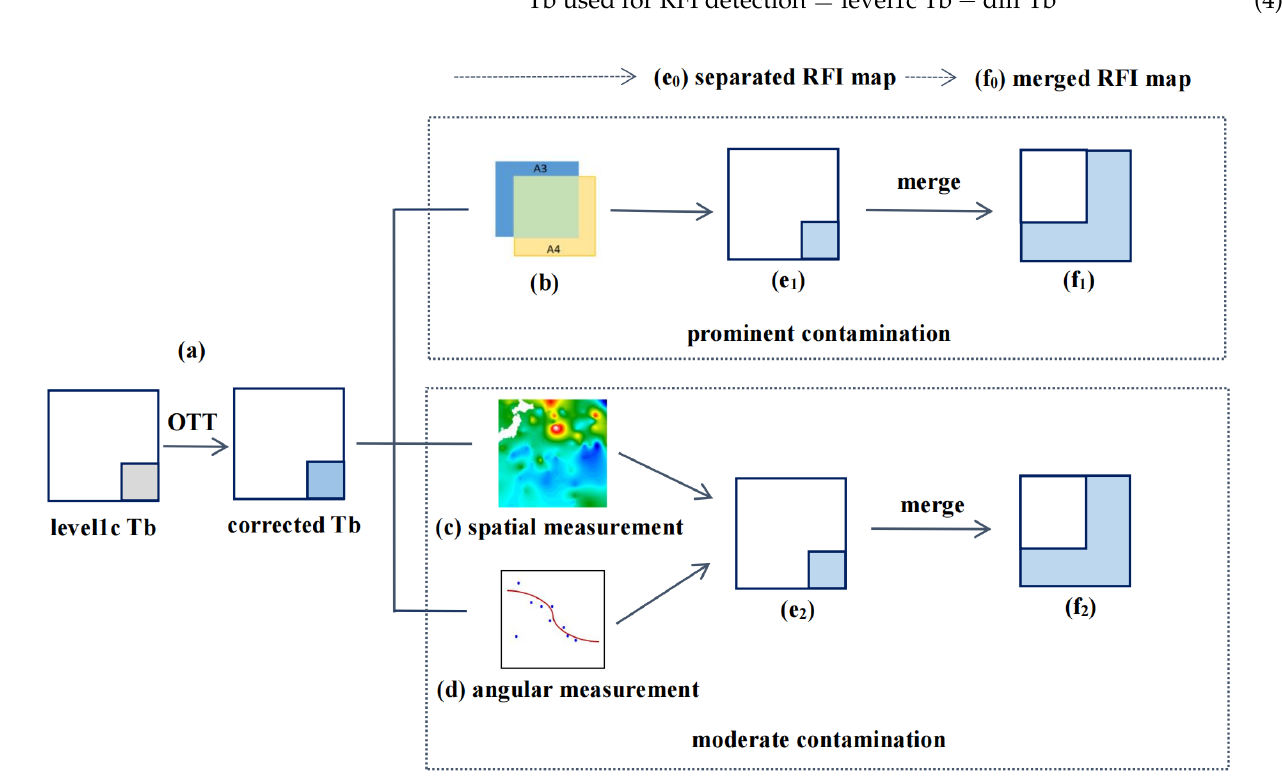
Figure 3. RFI detecting and measuring pipeline. Before the measurement, the level1c Tb must undergo ( a ) OTT to mitigate the instrument’s systematic error. Then, the corrected Tb is used to detect the prominent and moderate contamination simultaneously. ( b ) The A3 and A4 Stokes parameters are utilized to locate the prominent contamination. ( c ) The spatial and ( d ) angular measurements are operated in parallel to present the moderate contamination. Each SMOS pass will produce two ( e0 – e2 ) separated RFI maps (prominent and moderate) reflecting the condition of only the specific area. Furthermore, ( f0 – f2 ) the merged RFI map will be presented after merging all separated maps of the area of interest over an extensive